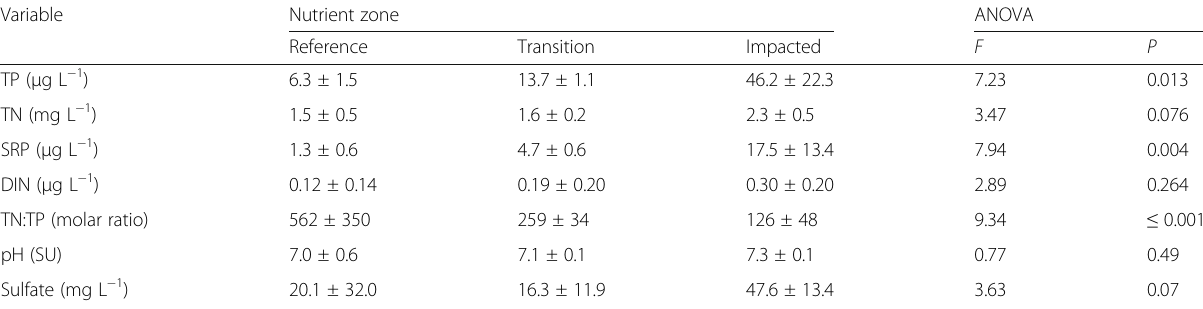
Table 1 Average nutrient and environmental variables and ANOVA results in reference, transition and impacted sites of several south Florida wetlands